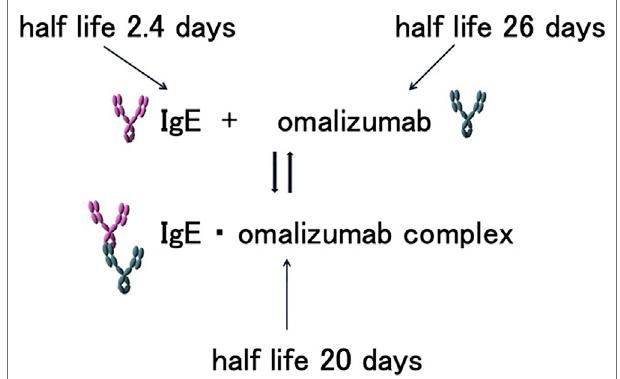
FIGURE 1 | Half-lives of IgE, omalizumab, and IgE-omalizumab complexes.IgE,omalizumab,andassociatedcomplexesmaintainabalanced state in the blood. The half-lives of IgE and its associated complexes differ, prolonging the half-life of serum IgE. As a result, the serum IgE concentration appears to be higher in the presence of omalizumab.